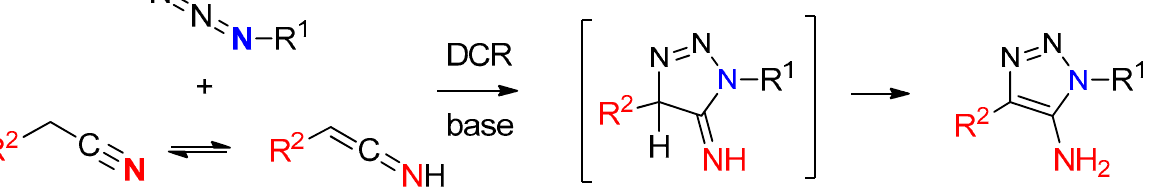
Figure 1. Potential application of 5-amino-1,2,3-triazoles N -substituted derivatives.